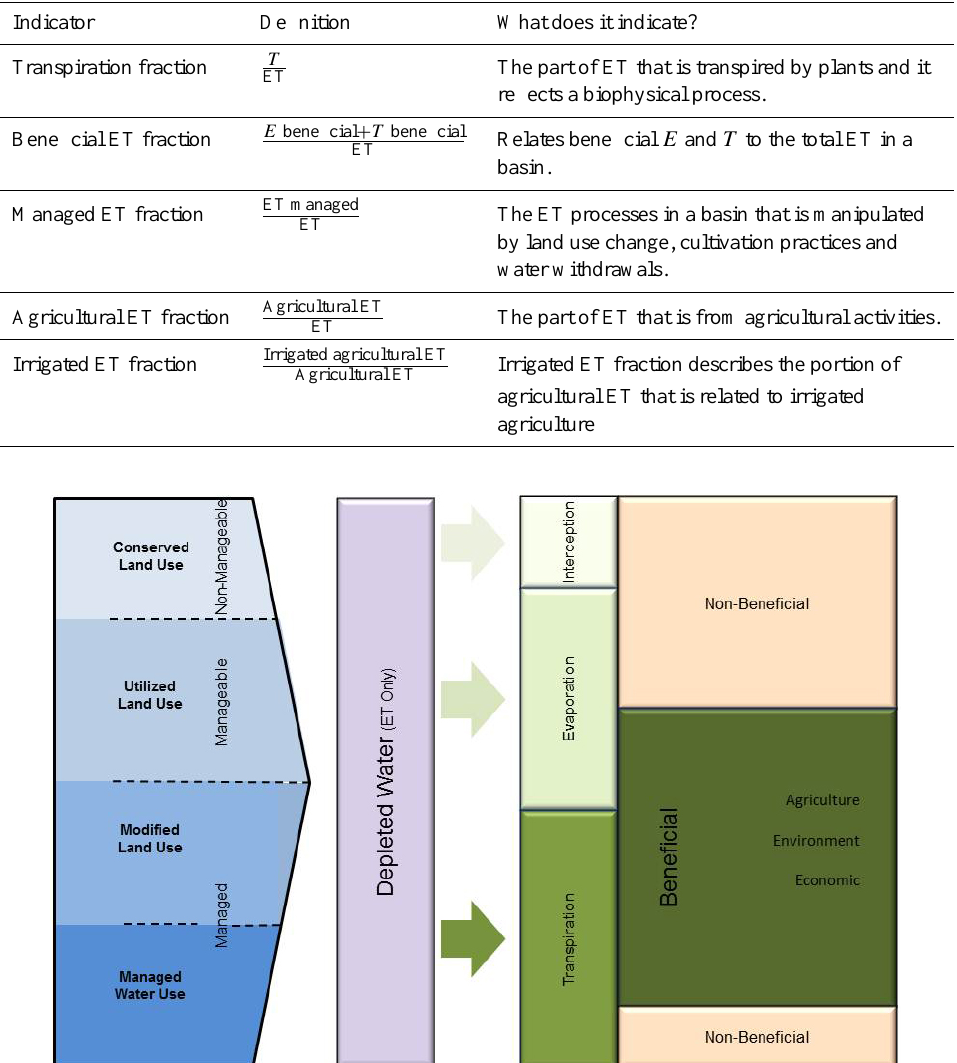
Figure 6. Schematic representation of the evapotranspiration